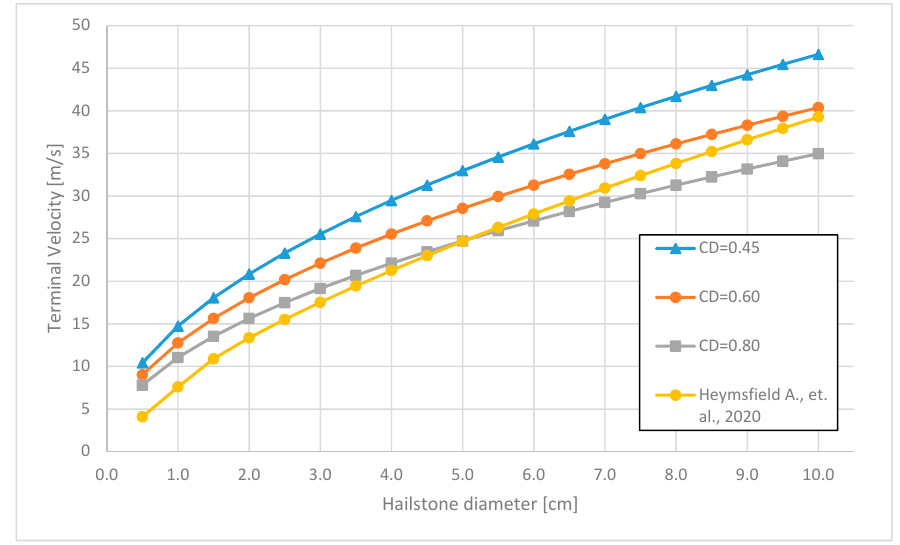
Figure 1. Relationship between spherical hailstone diameter and terminal velocity for different drag coefficients.